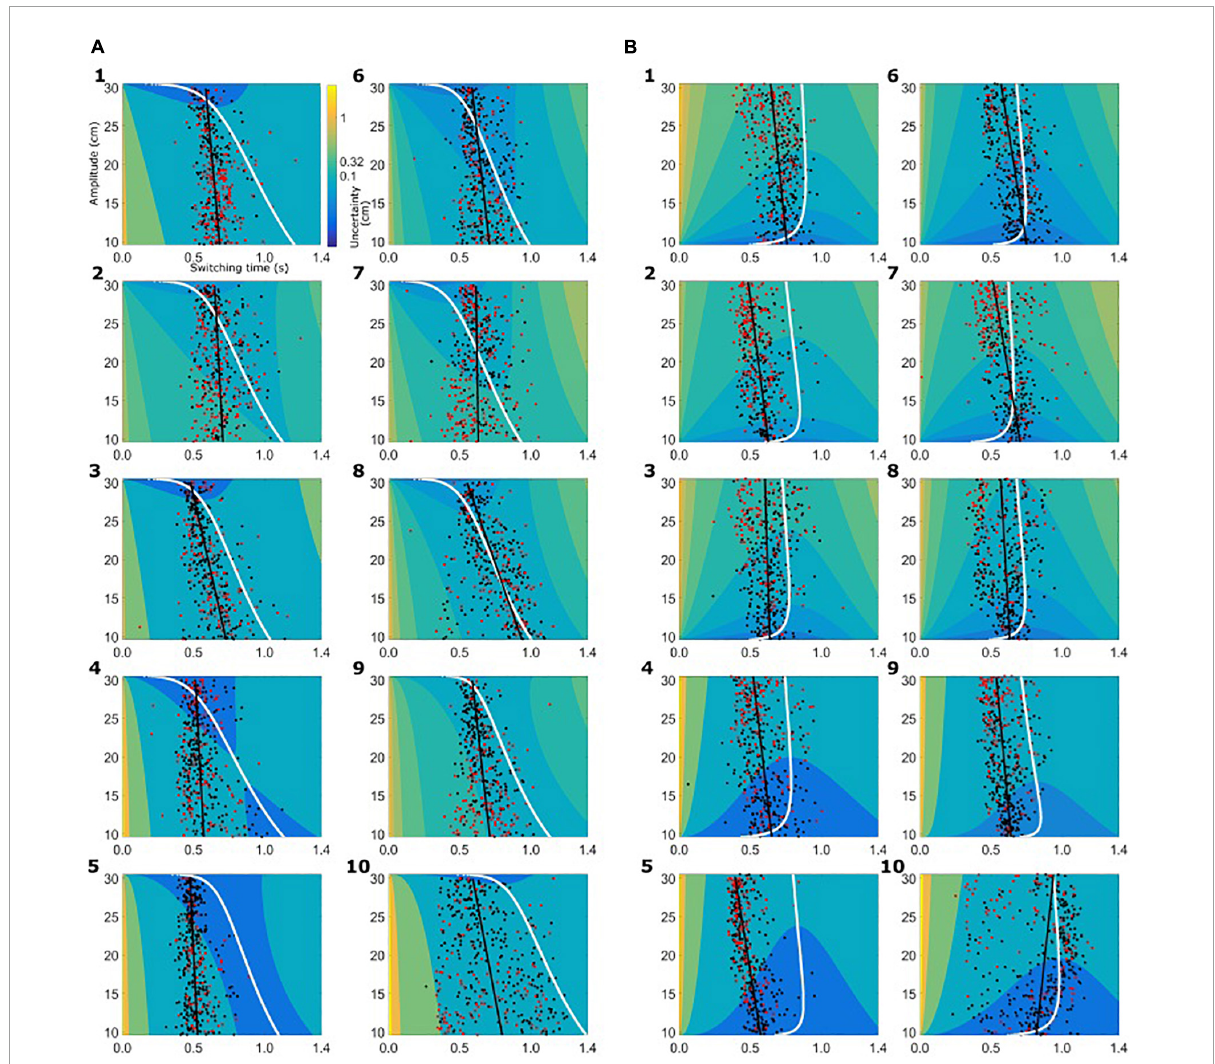
FIGURE4 Sensory-motor uncertainty and switching times for controls. For every subject the sensory-motor uncertainty map is shown as a function of movement amplitude (vertical axis) and viewing duration (horizontal axis). Warmer colors indicate greater value for combined sensory-motor uncertainty. For each amplitude, the combined sensory-motor uncertainty is high at the beginning of the trial and reduces in time, reaching the smallest value somewhere in the middle of the trial duration. The white curves indicate the time at which the combined sensory-motor uncertainty is at its minimum, and thus switching from sensing to acting would be optimal. The circular markers indicate the observed switching time. Black markers indicate successful catches, red markers unsuccessful catches. The black line represents the linear regression of the observed switching time with the amplitude. (A) Data from healthy controls for the condition where the ball starts from the left. (B) Data from the healthy controls for the condition where the ball starts from the right.